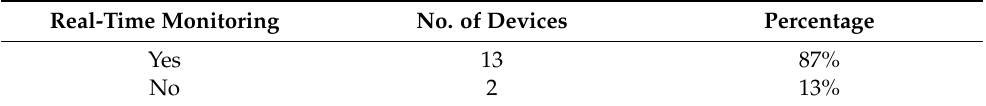
Table 5. Non-Commercial Wearables for Engagement Detection with Real-Time Monitoring. Real-Time Monitoring No. of Devices Percentage Yes 13 87% No 2 13%